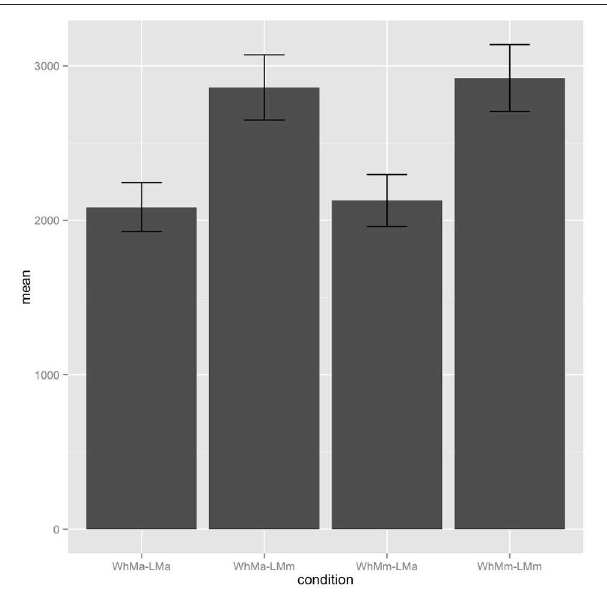
FIGURE 3 | Experiment 3 spillover region regression path